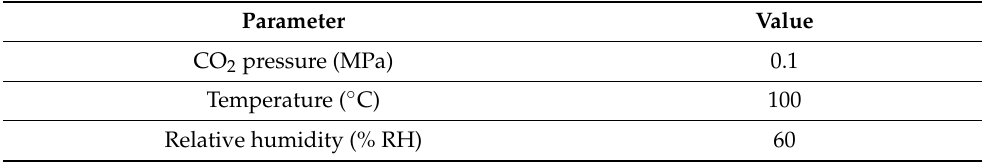
Table 4. Experimental conditions used in